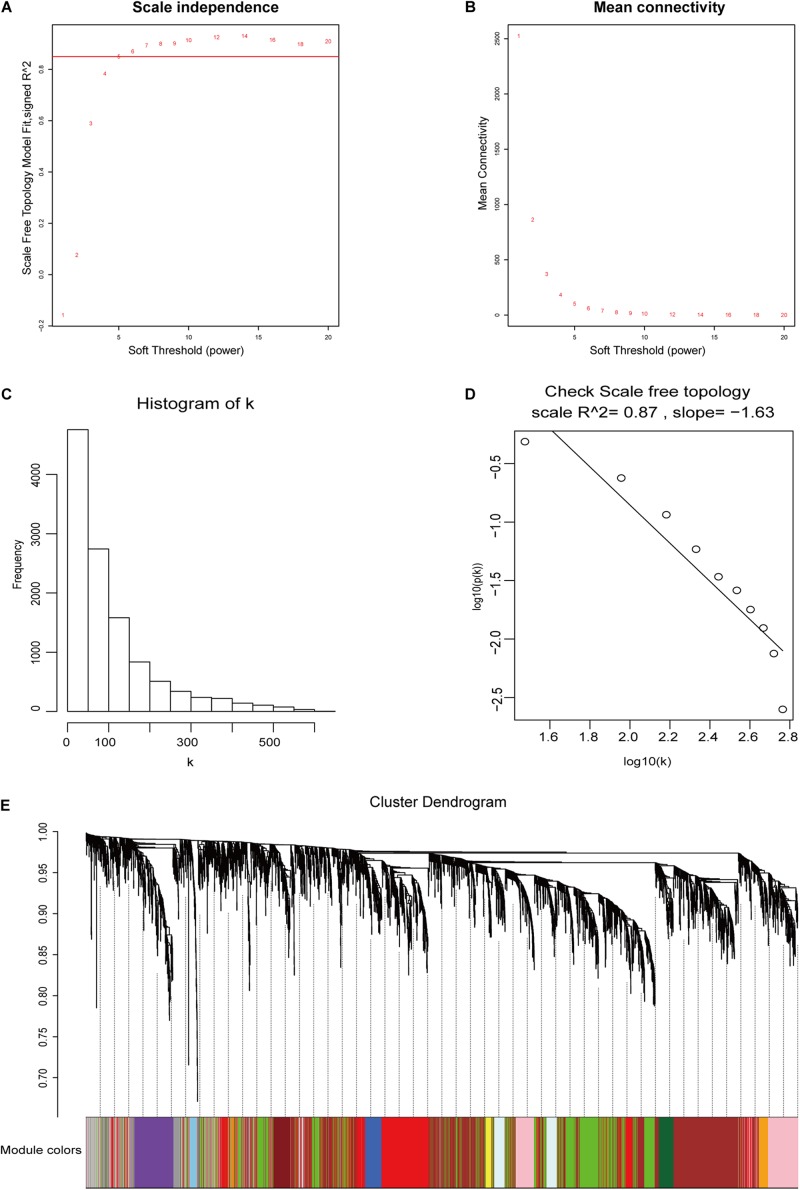
DEG weighted gene co-expression network construction. (A,B) The scale-free fit index and the mean connectivity with various soft-thresholding powers. (C,D) Histogram of connectivity distributions and check scale-free topology when β = 5. (E) DEG clustering dendrograms.